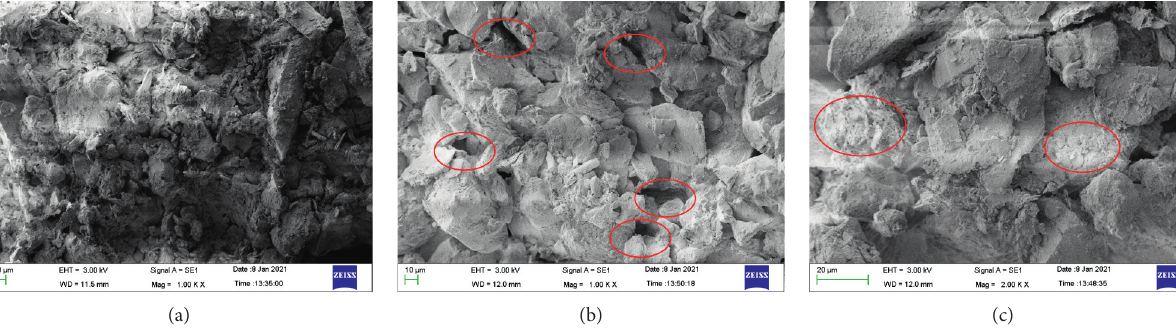
Figure 24: The microstructure of nonstabilized soil. (a) 0 cycles. (b) 7 cycles. (c) 10 cycles.